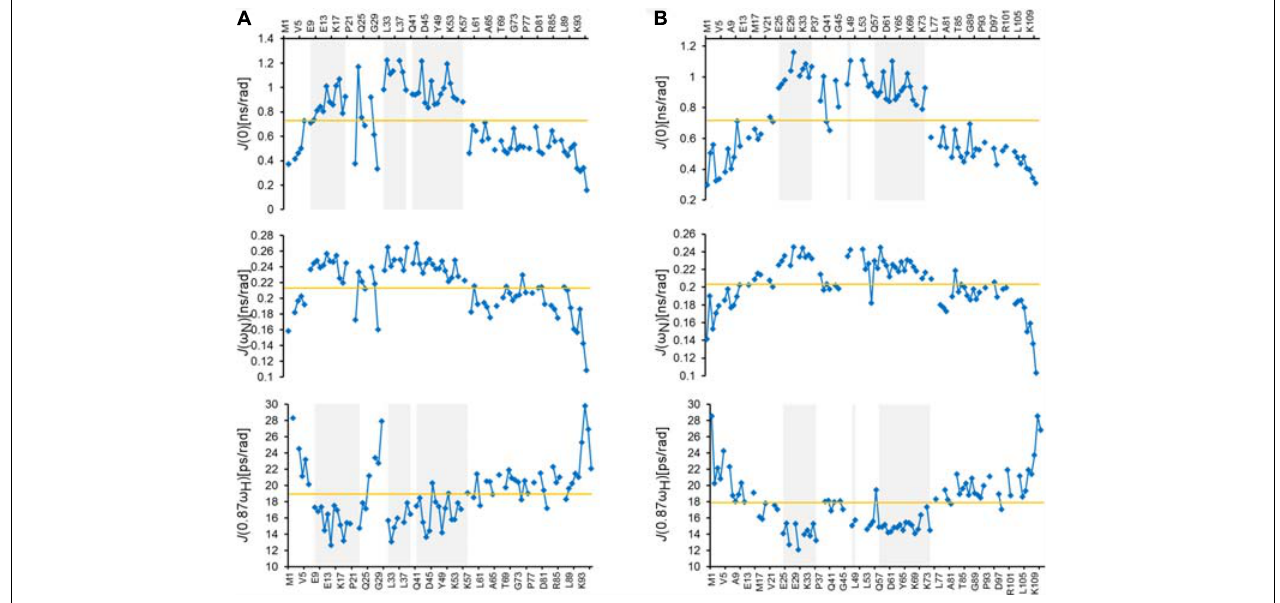
FIGURE 3 | ARPPs have flexible N- and C-terminus whereas the core regions have restricted backbone motions. Plots for the spectral density function values at J ( 0 ) , J ( ω N ), and J ( 0.87 ω H ) frequencies versus the residues of (A) ARPP-16 and (B) ARPP-19. Regions with restricted backbone motion are